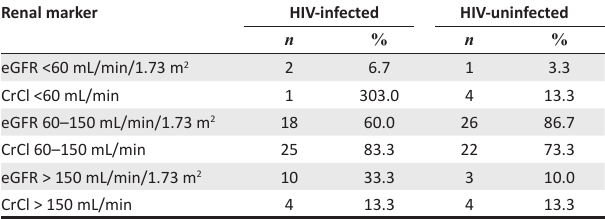
TABLE 3: Percentage eGFR and CrCl categories in HIV-infected and uninfected women ( n = 30). Renal marker